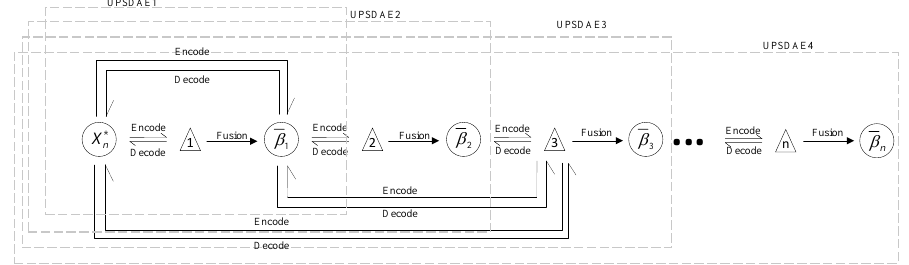
Figure 10. Schematic diagram of sUPSDAE fully connected network